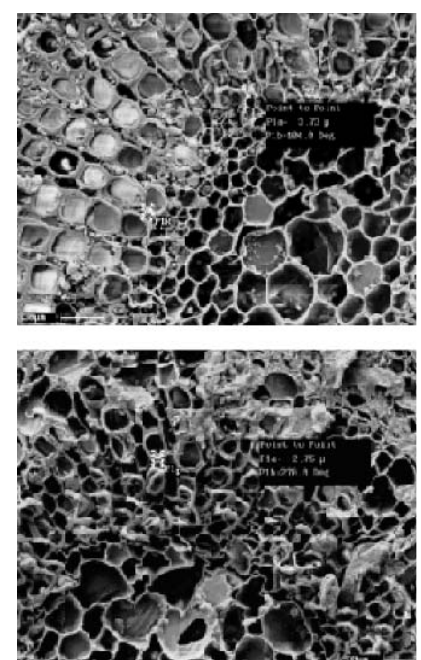
Figure 2. Central vein of leaves from coffee trees grown in adequate top) and deficient (bottom) B solutions. Xylem vessels are disorganized and the walls thinner in deficient plants.